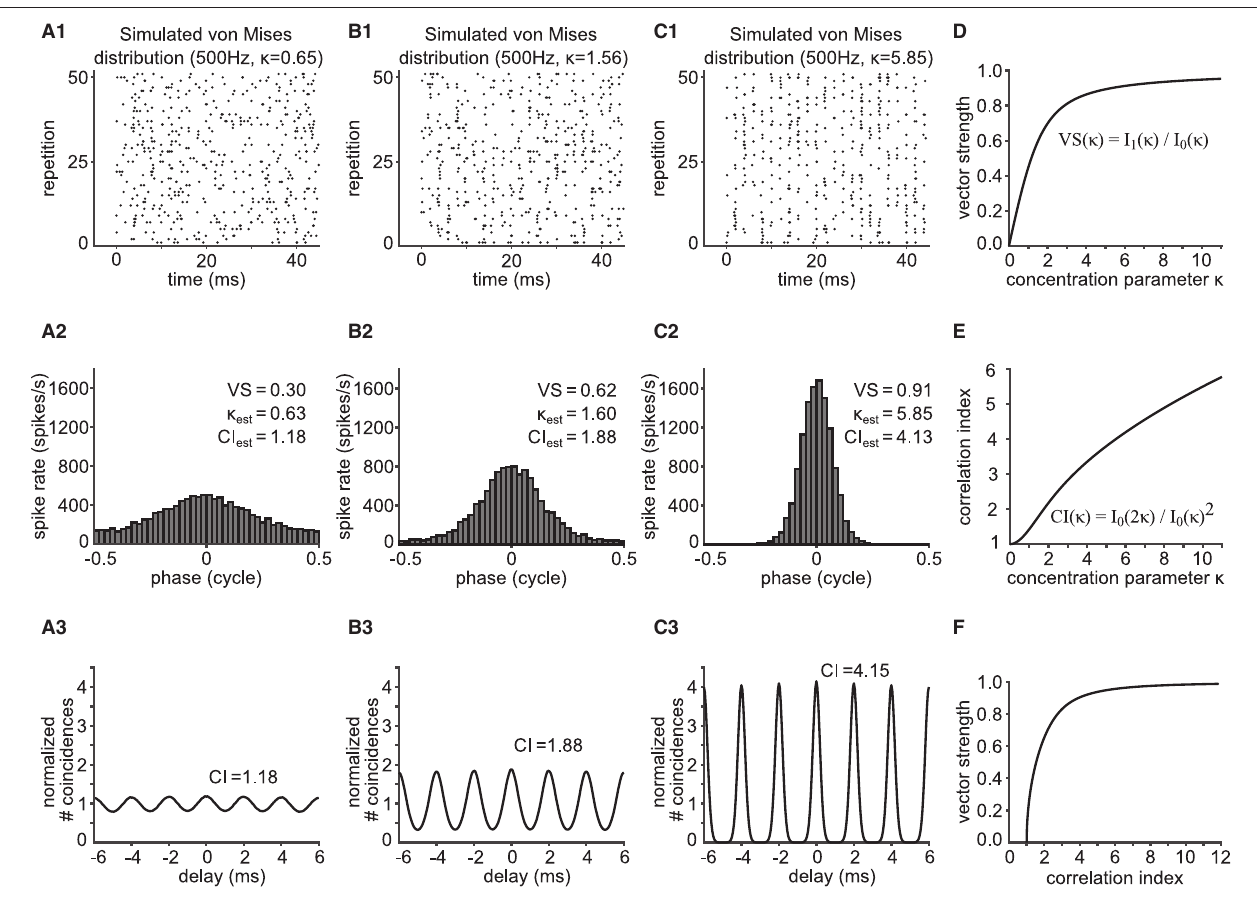
FIGURE 2 | Relationship between vector strength (VS) and correlation index (CI). (A1,B1,C1) Phase-locked spike trains simulated with an inhomogeneous Poisson process whose periodic intensity function is von Mises distributed. The raster plots show the spike occurrences for three different phase-locking strengths, namely κ = 0.65 (A1) , κ = 1.56 (B1) and κ = 5.85 (C1) . (A2,B2,C2) Corresponding phase histograms for the simulated spike trains in (A1–C1) . The resulting empirical VS is shown, together with its back-calculated κ and estimated CI value. (A3,B3,C3) SACs for the spike trains in (A1–C1) with corresponding empirical CI values. In (A1–C1) , only 51 trials are shown for clarity, while 400 trials of 150 ms trains were used for (A2–C2) and (A3–C3) . (D) Value of VS as a function of κ for the von Mises distribution. (E) Value of CI as a function of κ for the von Mises distribution. (F) Relation between VS and CI for varied concentration parameters κ of the underlying von Mises